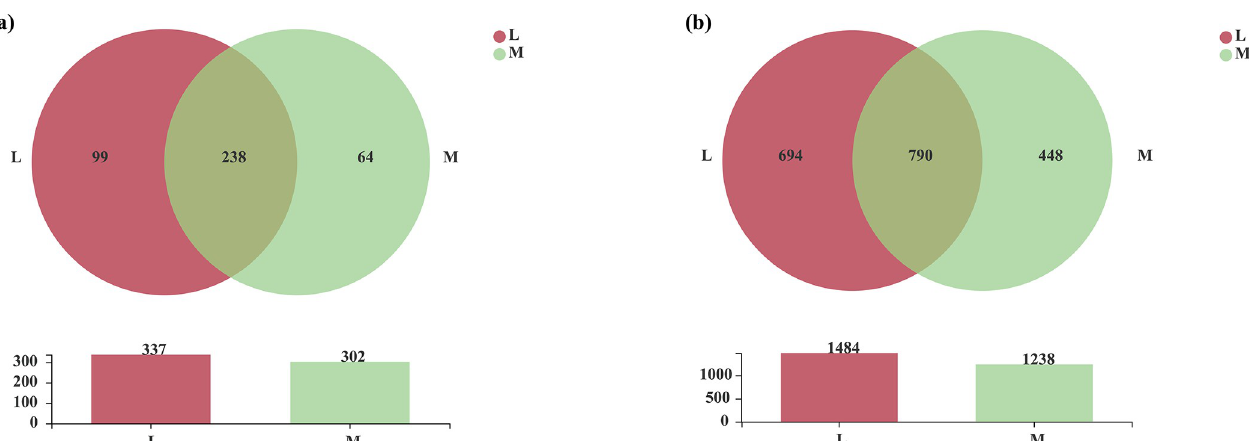
PLOS ONE | https://doi.org/10.1371/journal.pone.0278303 December30,